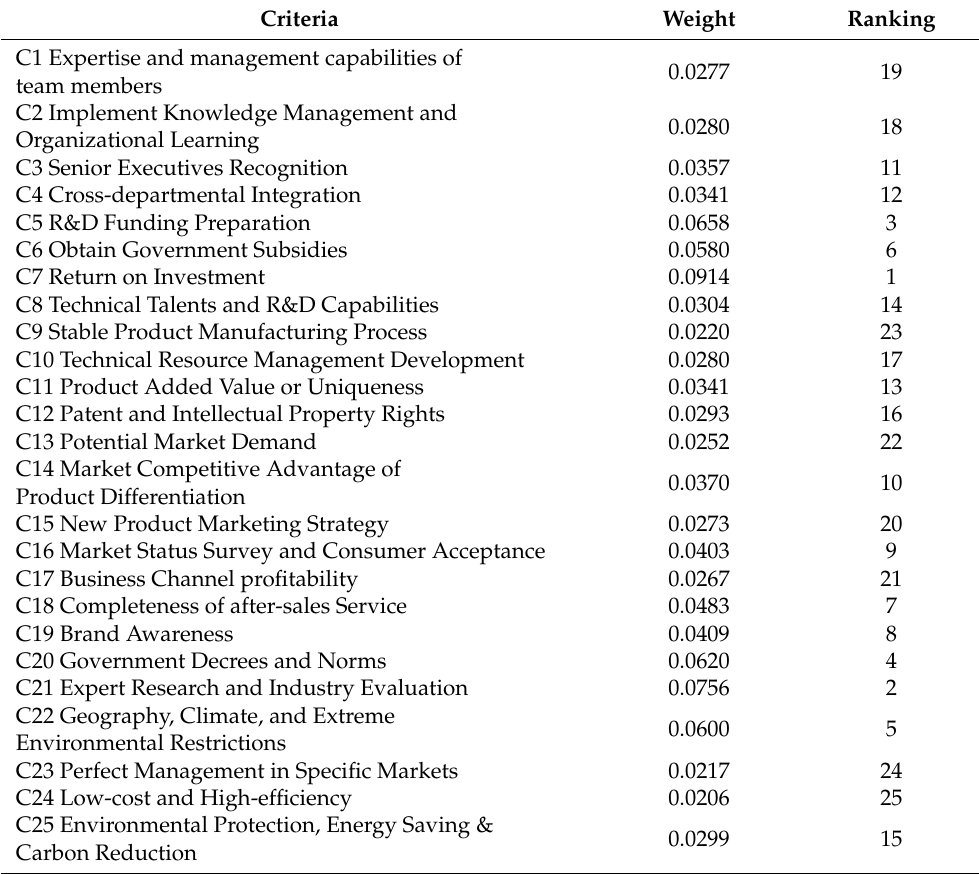
Table 11. The final relative weight of criteria of MCDM model for OLED NPD. Criteria Weight